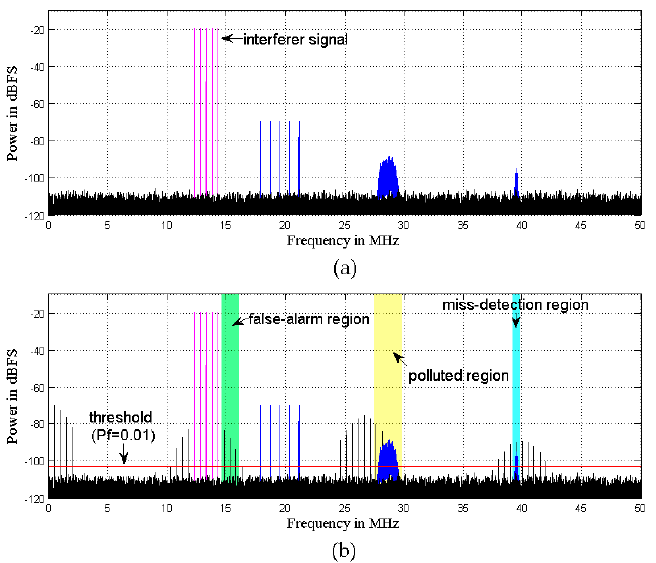
Figure 4. Typical simulation results of a distorted spectrum and the energy detection (ED) threshold: ( a ) original signal; ( b ) distorted signal.